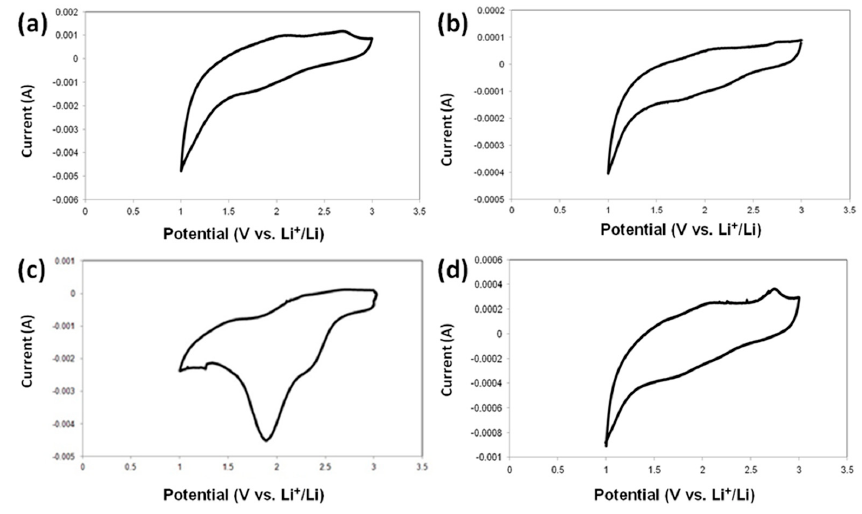
Figure 15. Cyclic voltammetry curves of MnO 2 |Li ( a ), MnO 2 /KL+A|Li ( b ), MnO 2 /KL+B|Li ( c ) and MnO 2 /KL+C|Li ( d ).